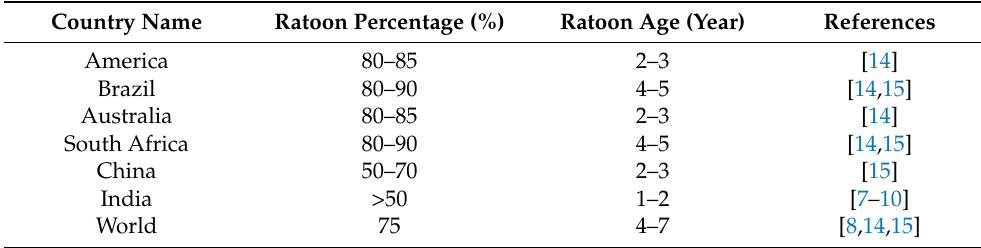
Table 1. Comparison of ratoon status in major sugarcane planting